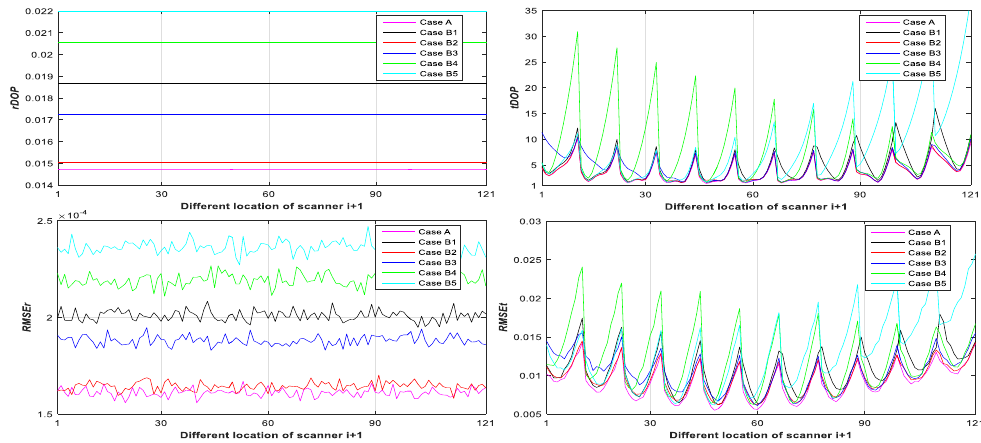
Figure 6. 4 rDOP , 4 tDOP , ,4 r RMSE , and ,4 t RMSE of Case A, B, C, and D with respect to Figure 6. rDOP 4 , tDOP 4 , RMSE r ,4 , and RMSE t ,4 of Case A, B, C, and D with respect to di ff erent Scanner different Scanner i + 1. i + 1.